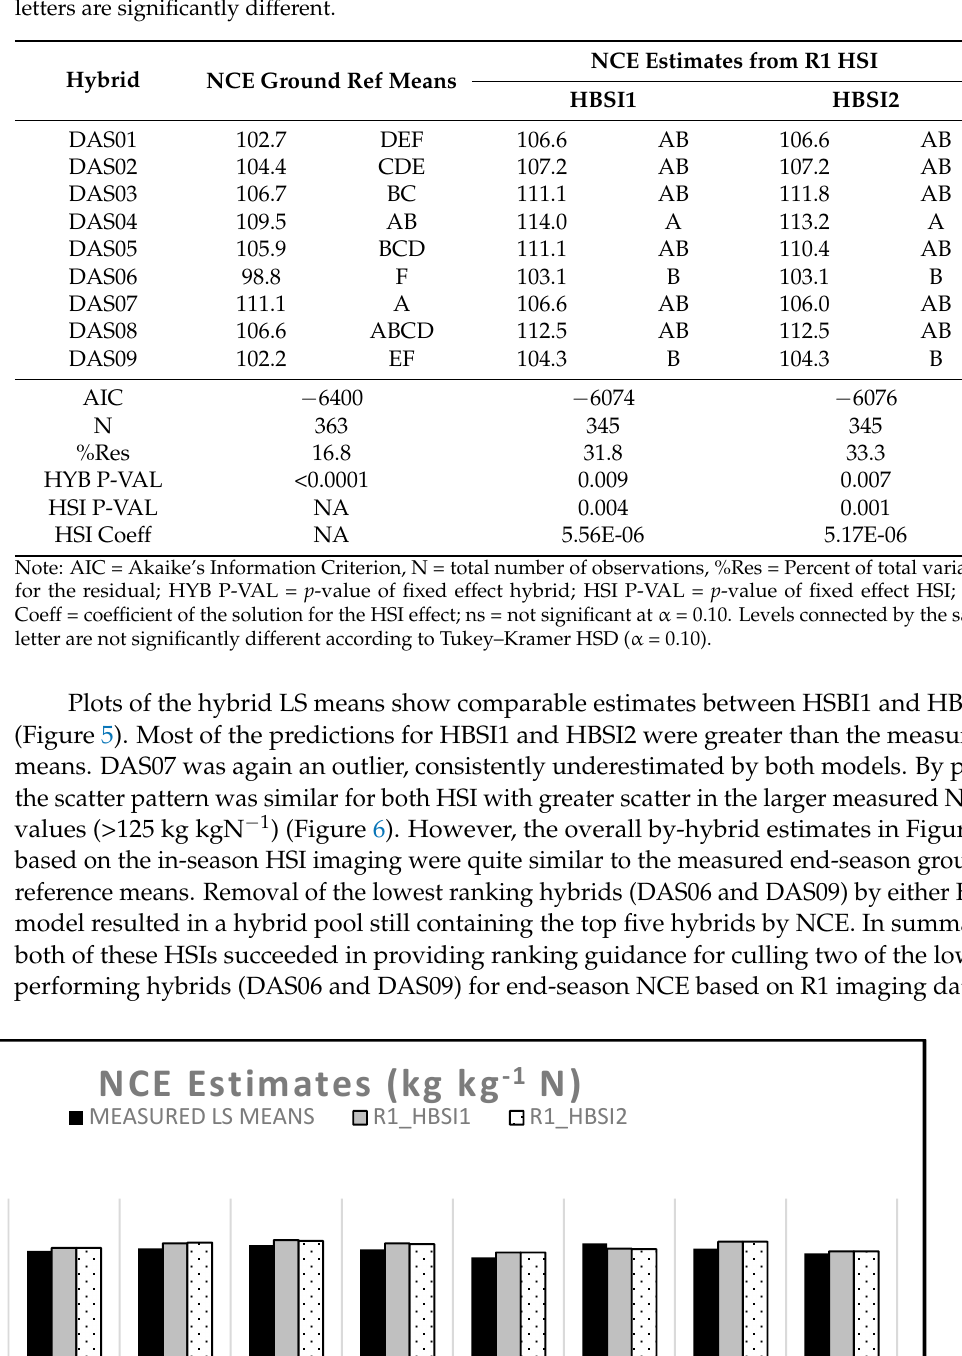
Table 8. NCE (kg kg − 1 N) least square means estimates and fit statistics. Hybrid means with different letters are significantly different.